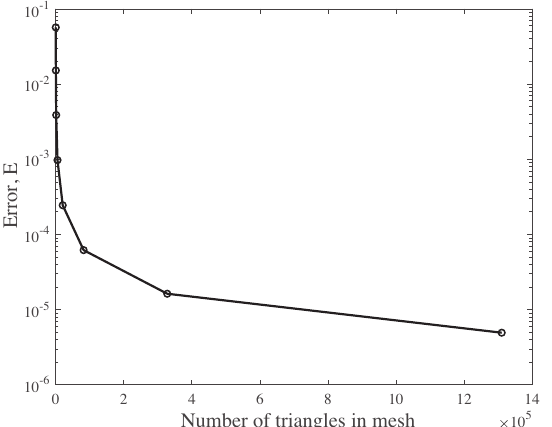
Figure 6. Numerical stability of the exact algorithm when computing the Zernike moments of discrete spheres. We plot the error in the numerical Zernike moments compared to the reference exact Zernike moments for a sphere (computed with Equation (40)) as a function of the number of triangles in the mesh represented the discrete